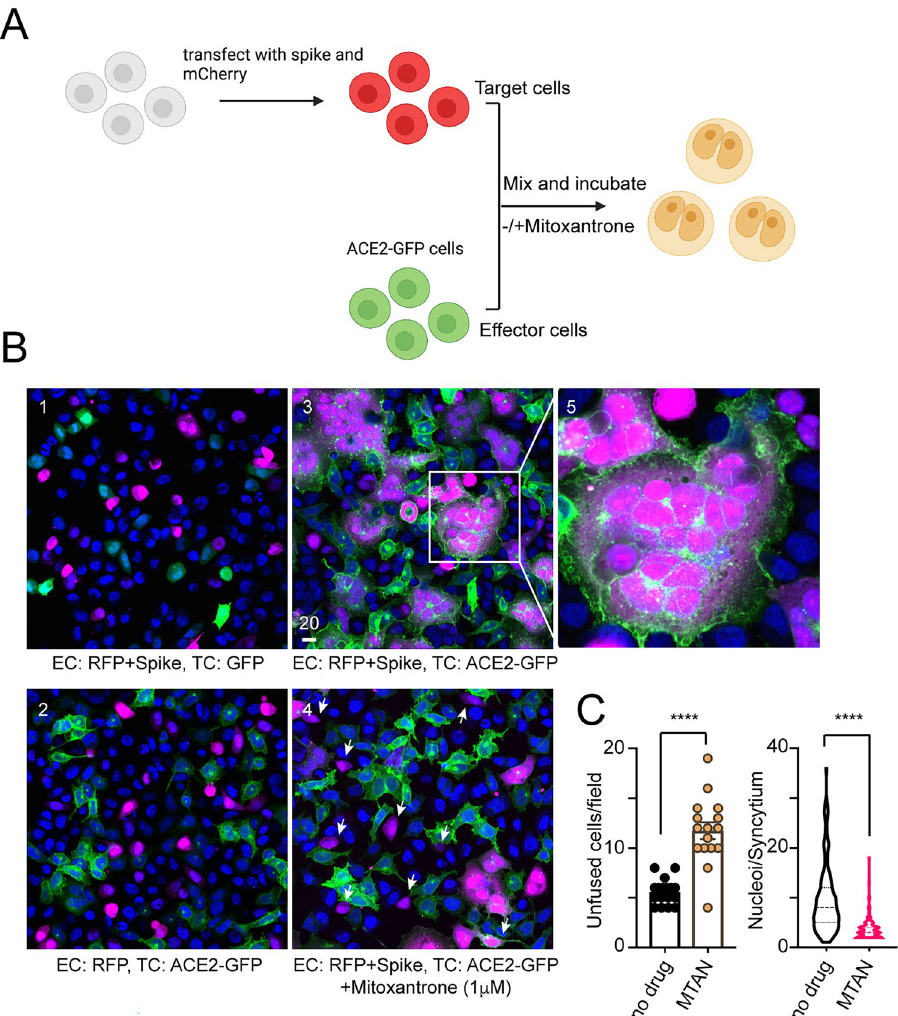
Figure 3. Mitoxantrone inhibits spike- and ACE2-mediated membrane fusion. (A) A scheme of the membrane fusion assay. (Created by Biorender.com). (B) Mitoxantrone inhibits spike and ACE2-mediated membrane fusion. Effect cells (EC) and target cells (TC) transfected with the indicated plasmids were mixed in equal numbers and cultured in the absence (panels 1–3) or presence (panel 4) of Mitoxantrone (1 μM) for 90 min. Cells were fixed and imaged by confocal microscopy. Panel 5 shows an enlarged view of the boxed area in panel 3. Arrows in panel 4 show example of unfused target cells. Scale bar, 20 μm. (C) Quantification of the experiments shown in (B) . The left panel shows the number of unfused cells/field, while the right panel shows the number of nuclei/syncytium. ****, p < 0.0001 by unpaired student’s t-test. n = 2 independent